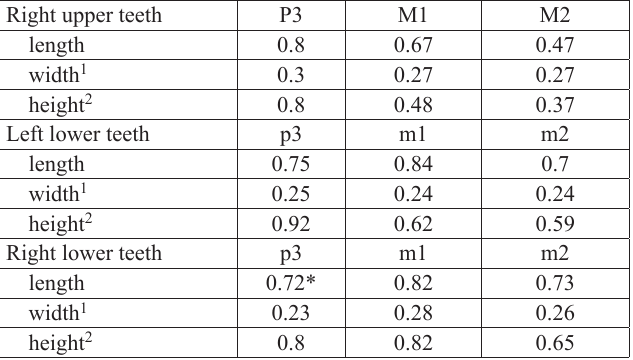
Table 1. Dental measurements (in mm) of the holotype of the mam- maliaform Hadrocodium wui (IVPP 8275) from the Lower Lufeng Formation, Lower Jurassic of China. 1 measurement of width across the primary cusp a; 2 measurement of height from below crown base at the depression of root junction to the apex of primary cusp a; * right p3 length is incomplete because anterior margin of the crown is slightly